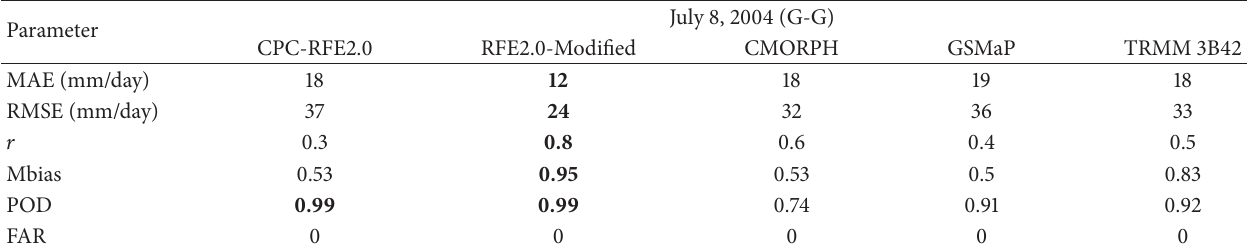
Table 3: Daily error statistics of satellite rainfall on July 8, 2004.